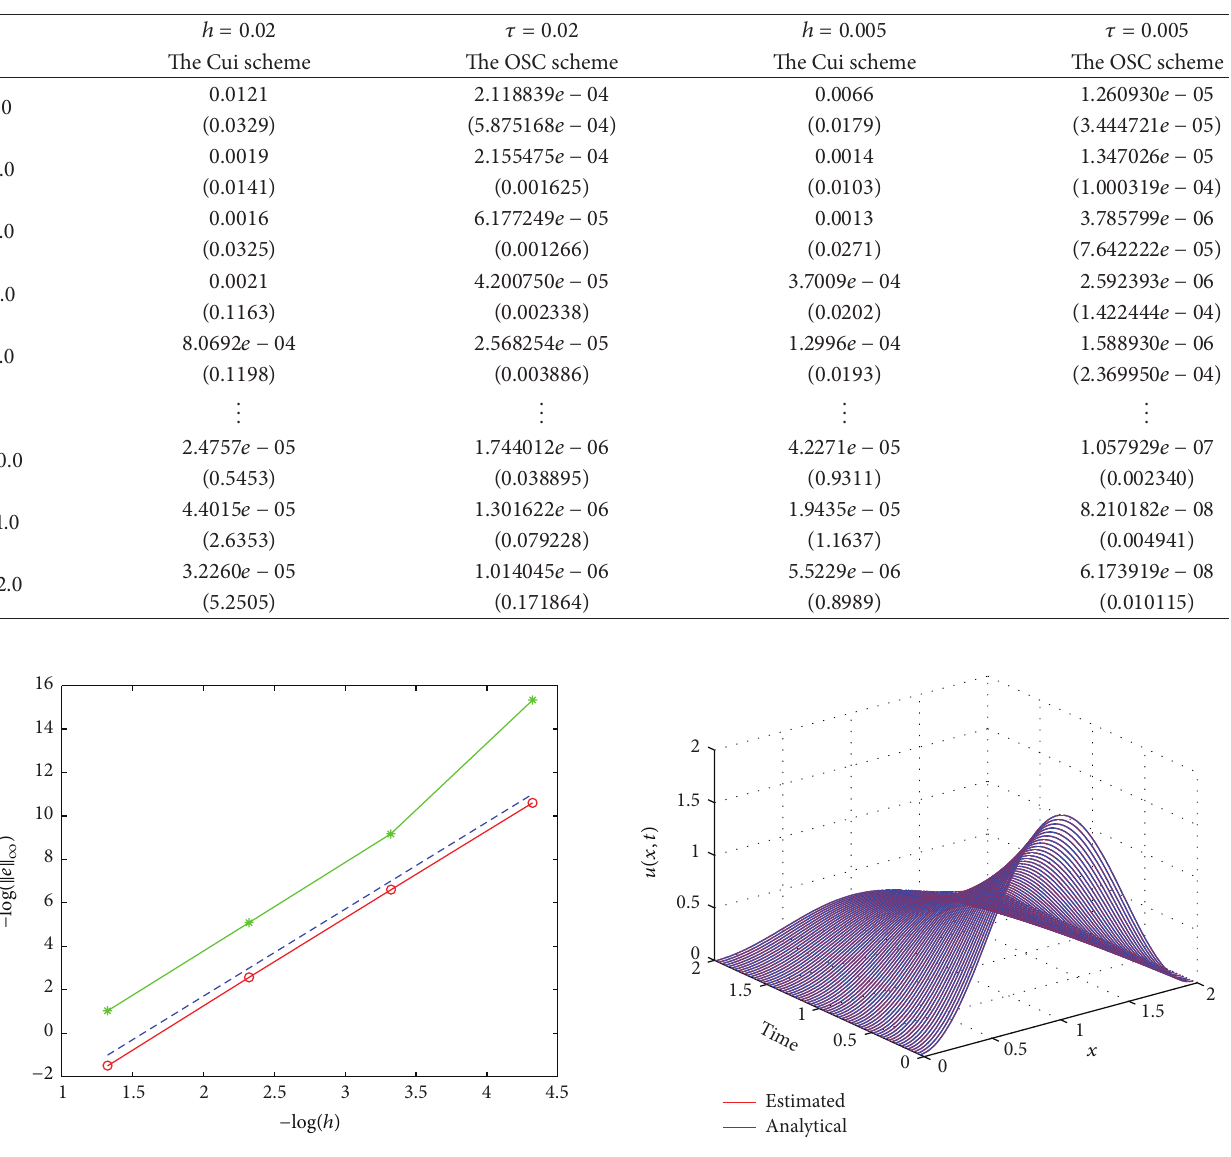
Figure 2: Space-time graph of the solution for Example 1 up to 𝑡 = 2.0 with 𝜏 = 0.01 and ℎ = 0.01 , analytical solution with blue color and estimated solution with red